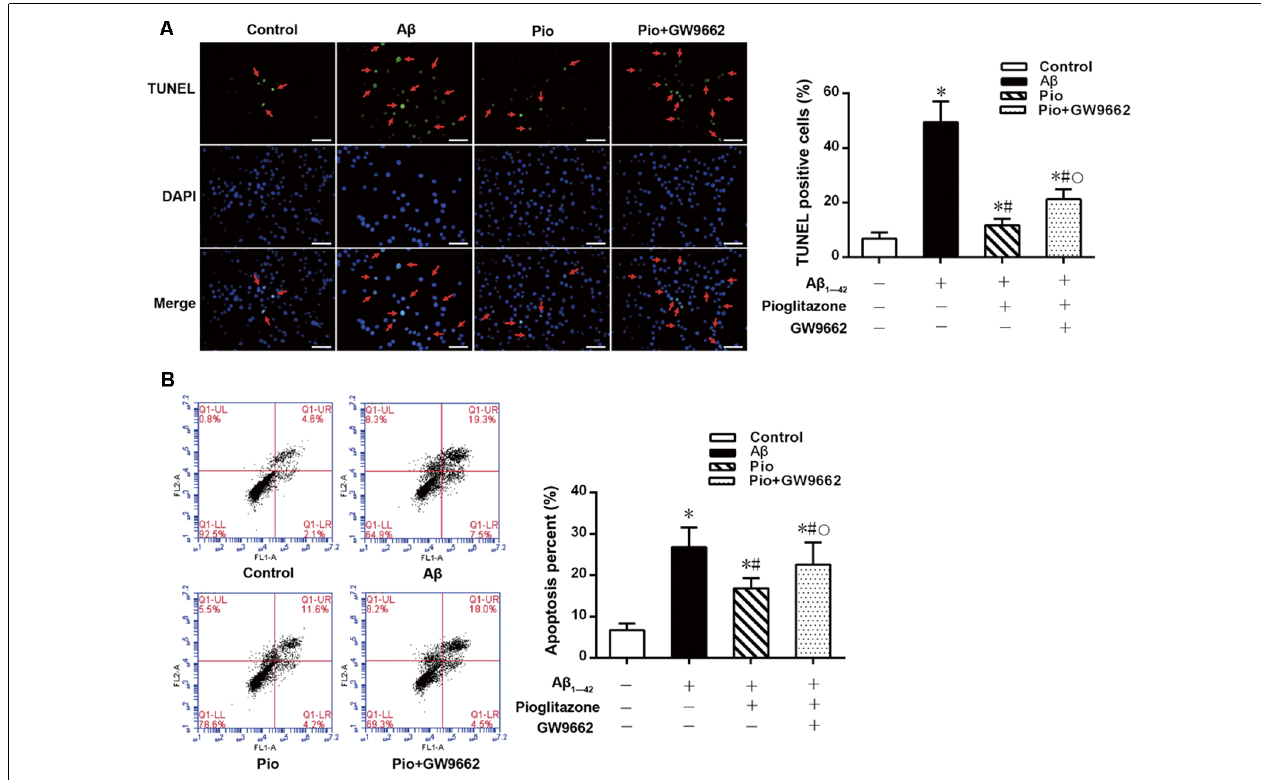
FIGURE 1 | Effects of pioglitazone on β amyloid (A β ) 1–42 induced apoptosis in rat hippocampal neurons. (A) Results of Terminal deoxynucleotidyl transferase dUTP nick end labeling (TUNEL) staining. Green represents nuclei with positive TUNEL staining (indicated by red arrows), and blue represents nuclei counterstained with DAPI. Scale bar, 50 µ m. (B) Results of flow cytometry. n = 6 wells per group. ∗ P < 0.05 compared to the control group, # P < 0.05 compared to the A β group, ◦ P < 0.05 compared to the Pio group.